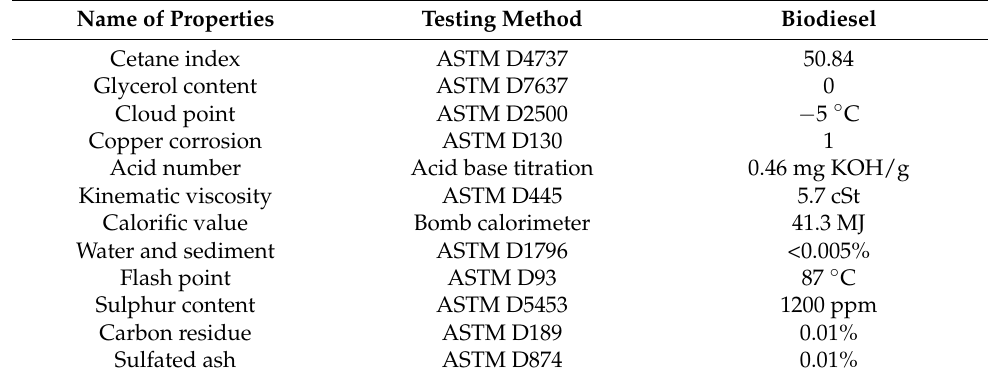
Table 4. Biodiesel Properties.